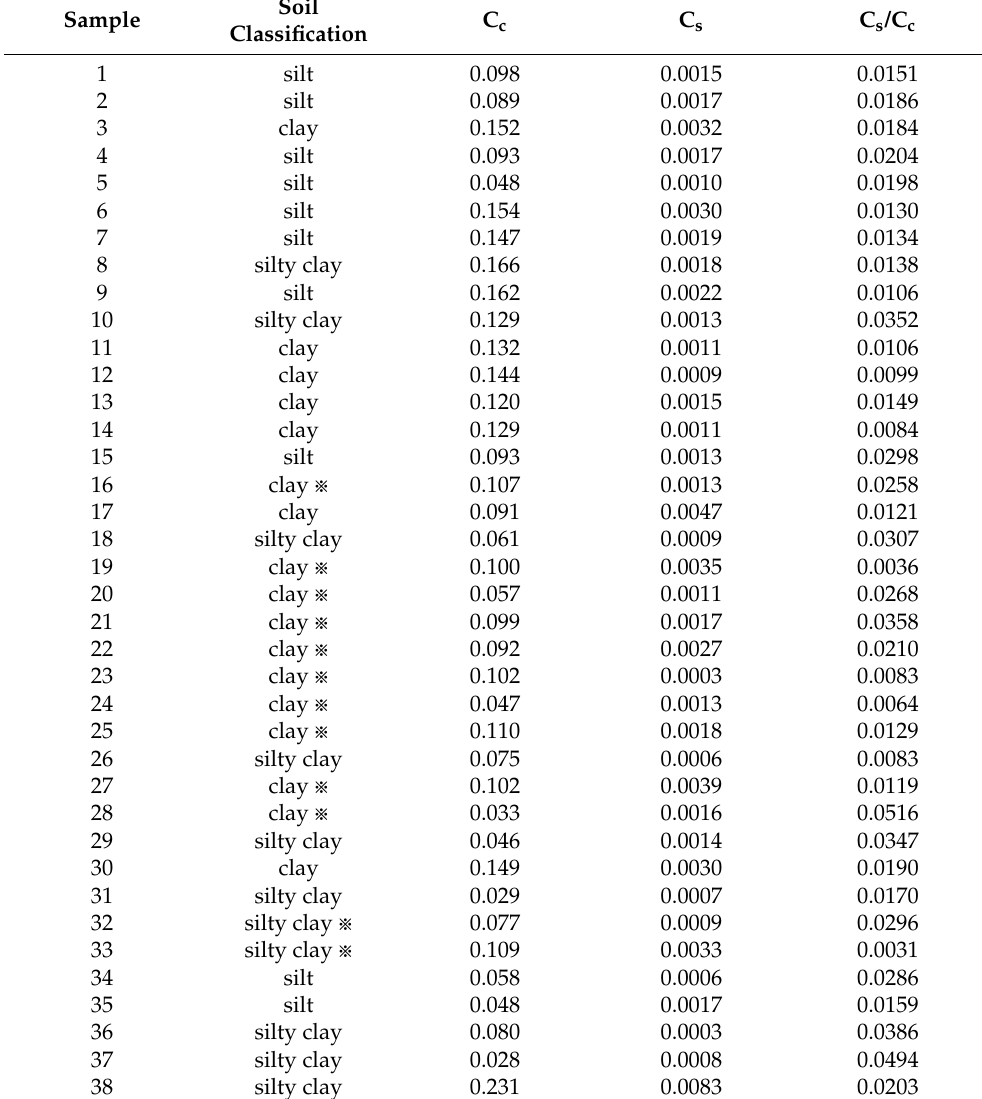
Table 4. Relationship between soil secondary consolidation index and compression